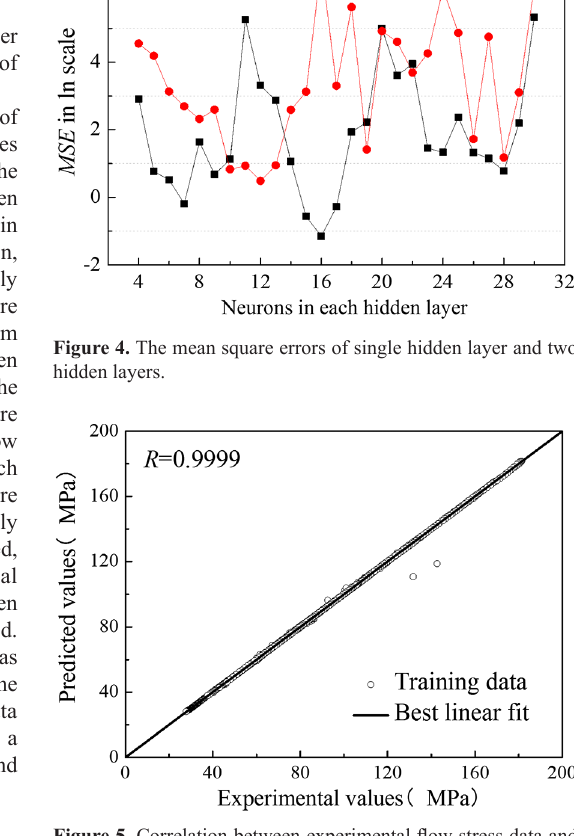
Figure 5. Correlation between experimental flow stress data and predicted flow stress data for the training dataset of BP-ANN